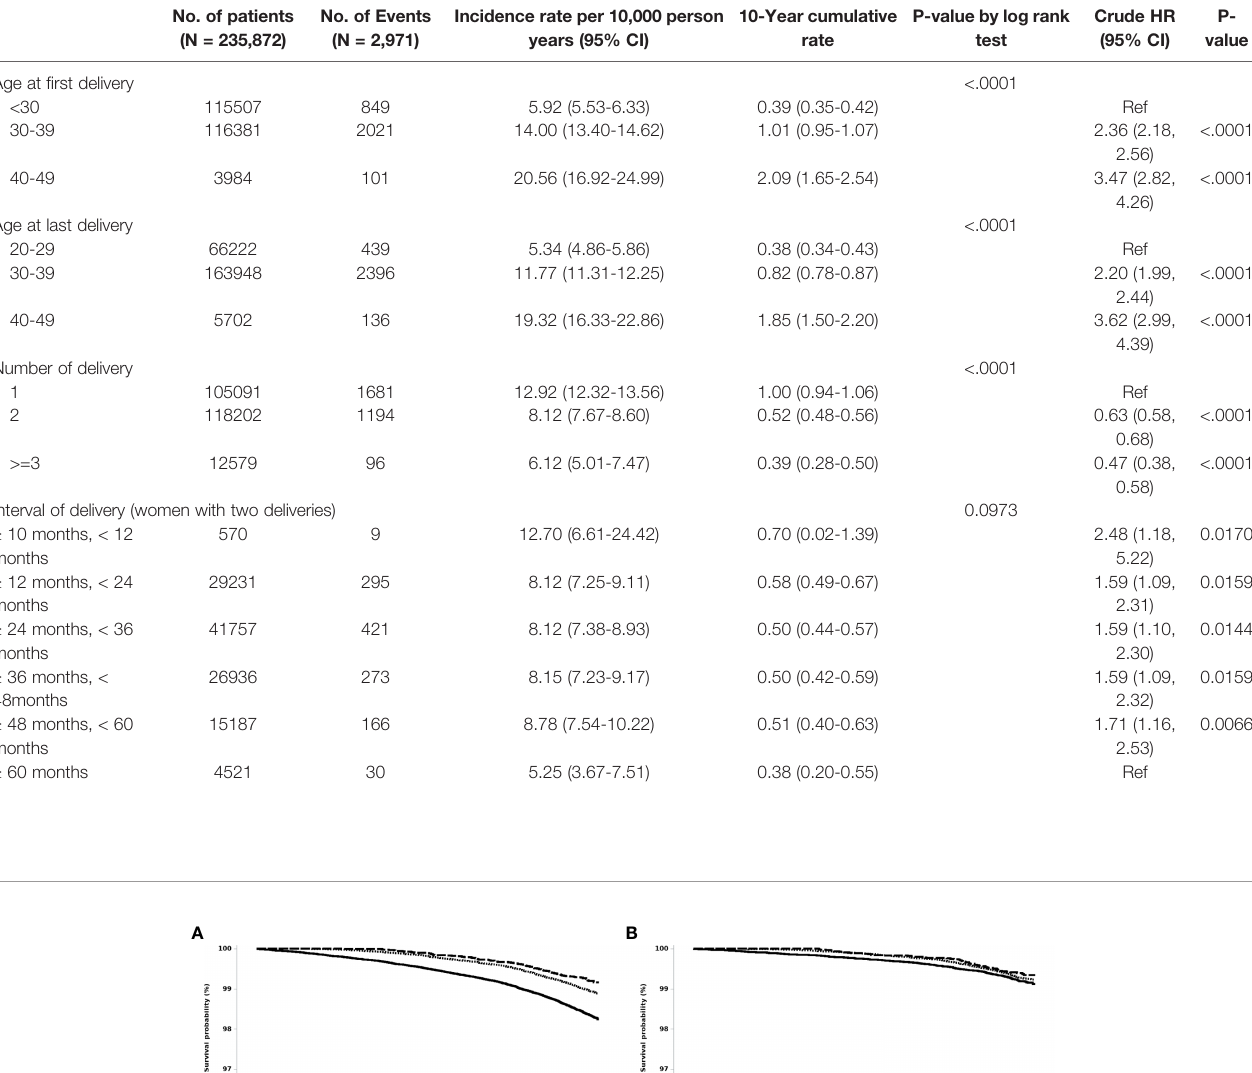
TABLE 2 | Incidence rate of breast cancer in women who had fi rst delivery in 2007. No. of patients (N = 235,872)